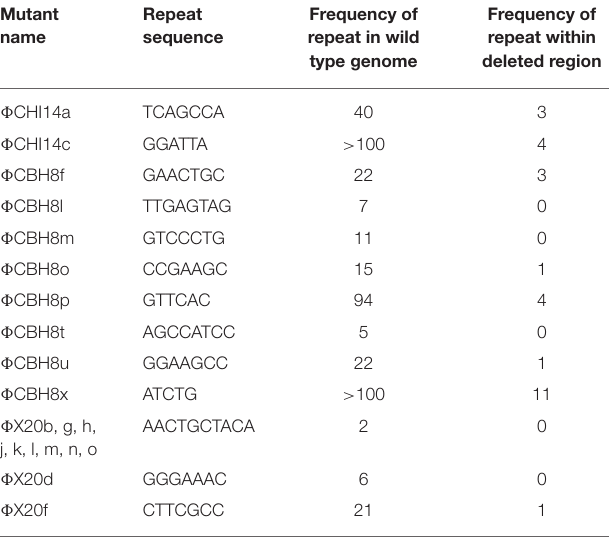
TABLE 3 | Sequences of direct repeat flanking the “large deletion” region in mutants are shown. Mutant name